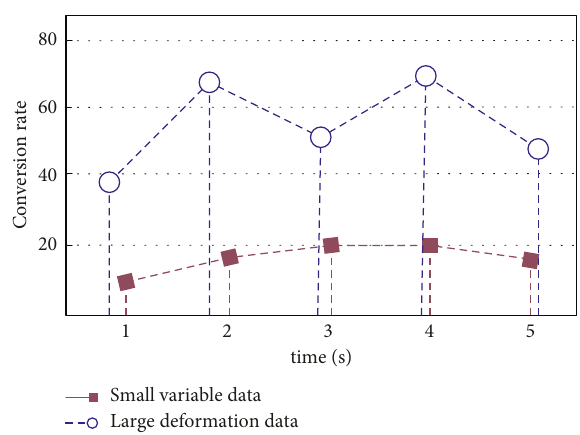
Figure 3: Picture data information conversion